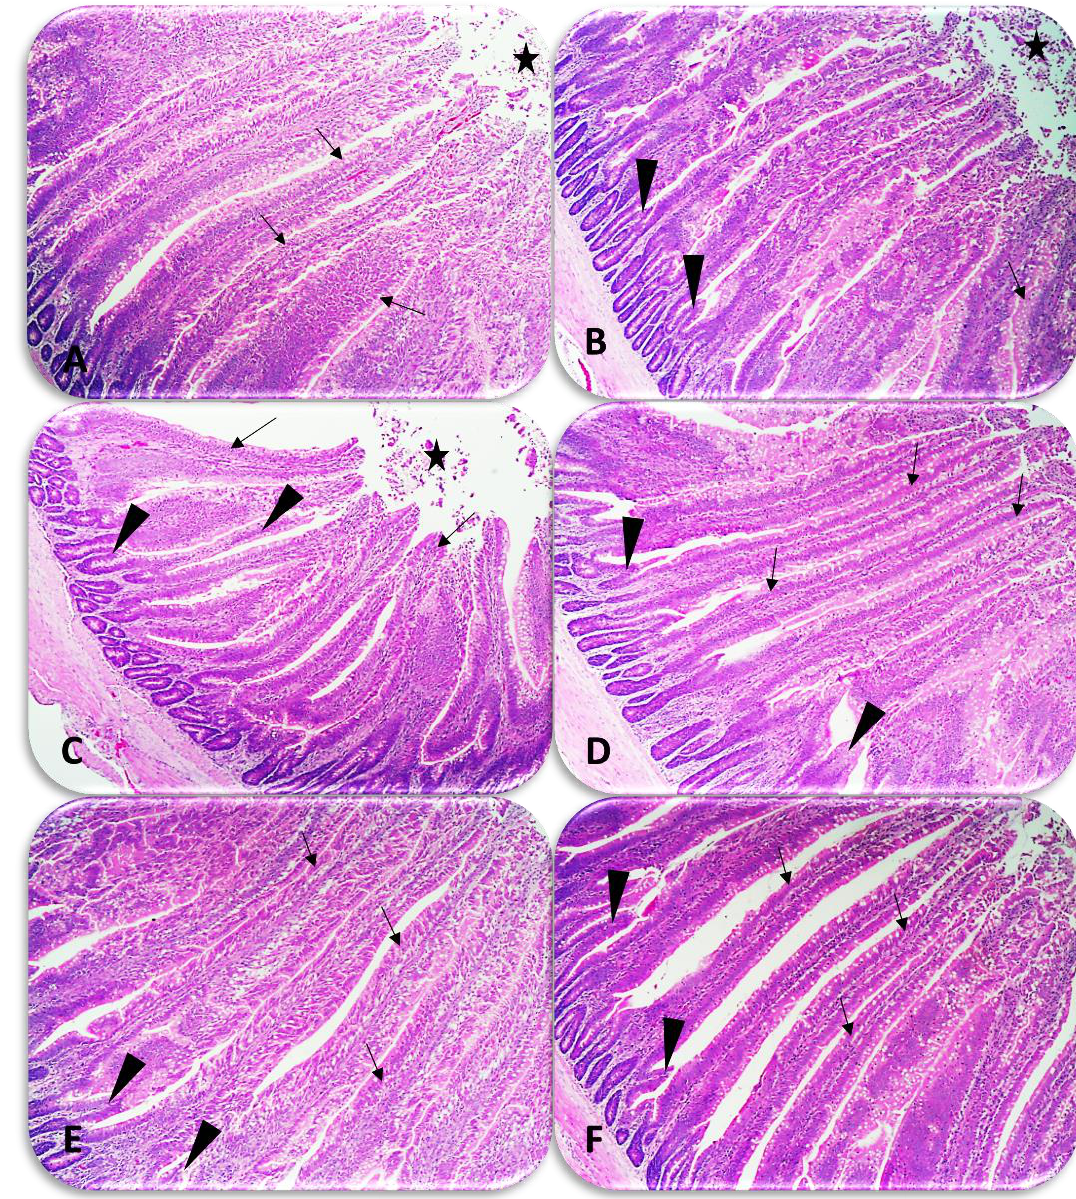
Figure 2. Representative photomicrographs of histopathological examination of broiler chicken’s duodenum samples on d 10 of age stained with hematoxylin and eosin (100×). ( A ): duodenum of chickens (0.00% GA) showing proliferative and some denuded villus enterocytes with abundant goblet cells (arrow), desquamated epithelial sheets inside the lumen (star). ( B ): 0.12% GA, villus structure was nearly high with abundant goblet cells, still found desquamated epithelial sheets in the lumen (star), and proliferative enterocytes (arrow) with crypts appeared to have high compensatory regenerative activity (arrowhead). ( C ): 0.25% GA showing the enterocytes and all villus coats were nearly better than 0.0 and 0.12% GA (arrow) with still faint mucus and desquamate in the lumen (star). Clear regeneration events from deeper intestinal crypts (arrowhead) was observed. ( D – F ): levels 0.50, 0.75, and 1.0% GA, respectively, morphological appearance, including villus coats and enterocytes layers were improved than chickens of other GA levels (arrow) and all crypts have regenerative activity (arrowhead).